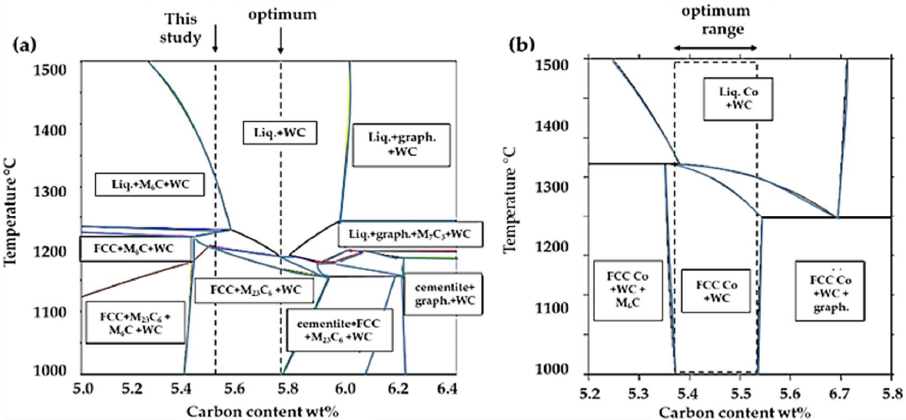
Figure 1. Phase diagram of ( a ) WC-Fe-8Cr system and ( b ) WC-Co system [26] as a function of temperature and carbon weight fraction. Although no two-phase region exists for WC-Fe-8Cr, there is a desired region where the liquidus temperature is minimized. The dotted lines indicate this optimal region of carbon content (about 5.7 wt.%) vs. the carbon content for substrate materials in this study (5.5 wt.%).